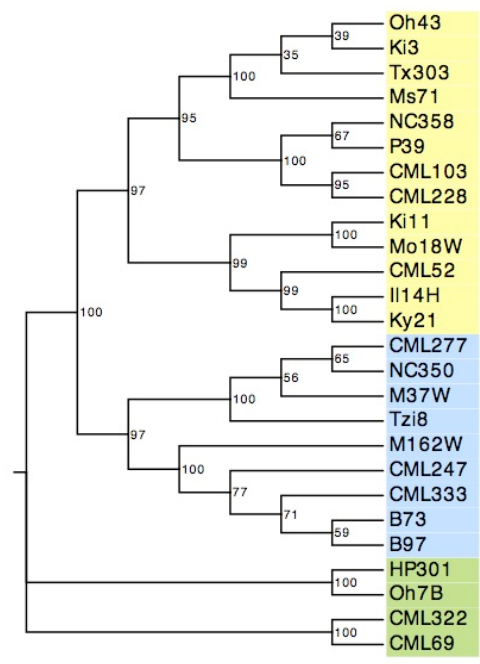
Figure 6. A phylogenetic tree based on SAT genetic distance for NAM founders. The evolutionary tree is inferred using the UPGMA method. The bootstrap consensus tree is inferred from 1000 replicates. The NAM founders are divided into three groups, labeled with yellow, blue and green. Oh43, Ki3, Tx303, Ms71, NC358, P39, CML103, CML228, Ki11, Mo18W, CML52, Il14H, Ky21, CML277, NC350, M37W, Tzi8, M162W, CML247, CML333, B97, HP301, Oh7B, CML322 and CML69 represent the